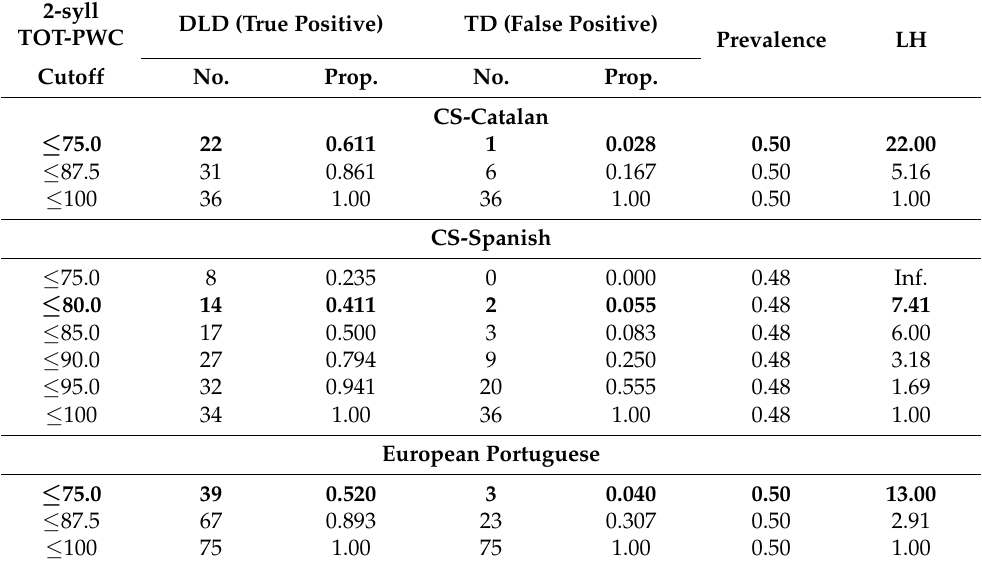
Table 7. The number and proportion of children with a positive test result (ruling in disorder), prevalence and likelihood ratio (LH) for each of the cutoff value based on total word percentage correct (TOT-PWC) for 2-syllable length nonwords for the Catalan–Spanish (CS) and European Portuguese (EP) children with developmental language disorder (DLD) and typically developing (TD)